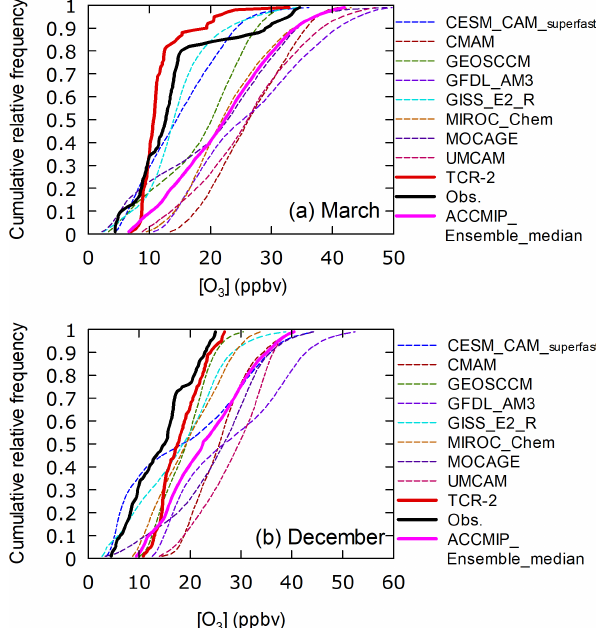
Figure 12. Cumulative relative frequency distributions of O 3 mix- ing ratios from observations (black), TCR-2 (red), and members and ensemble median of ACCMIP for domain 3 (0–15 ◦ N and 150– 165 ◦ E) in (a) March and (b)